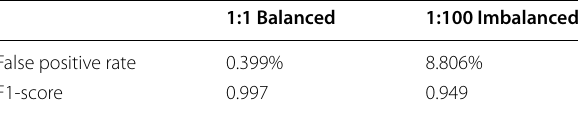
Table 1 Effect of imbalanced dataset in DeepReturn 1:1 Balanced 1:100